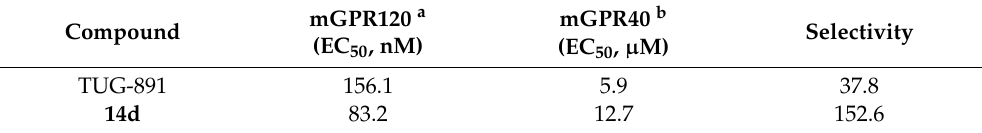
mGPR120 a (EC 50 , nM)